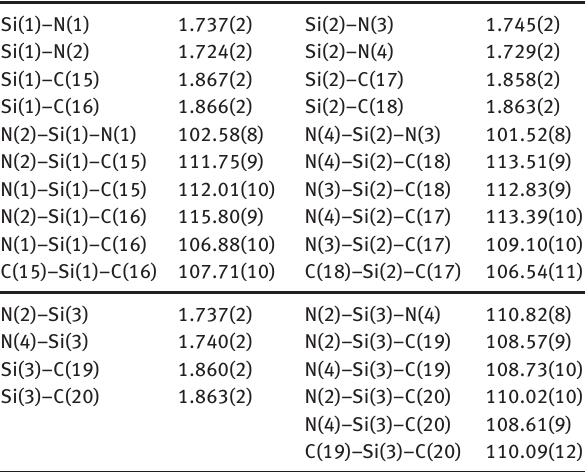
Table 7: Selected geometric parameters (Å, °) of